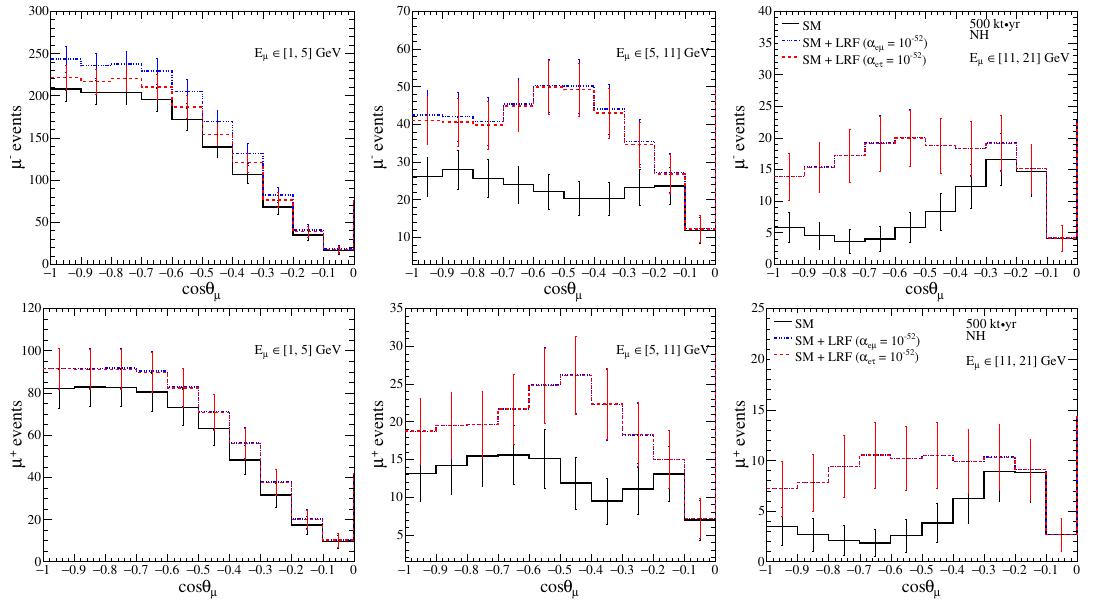
Figure 8 . The distributions of (cid:22) (cid:0) (upper panels) and (cid:22) + (lower panels) events for three di(cid:11)erent E (cid:22) bins: 1 to 5 GeV in left panel, 5 to 11 GeV in middle panel, and 11 to 21 GeV in right panel. In each panel, we consider three di(cid:11)erent cases: i) (cid:11) e(cid:22) = (cid:11) e(cid:28) = 0 (the SM case, black solid